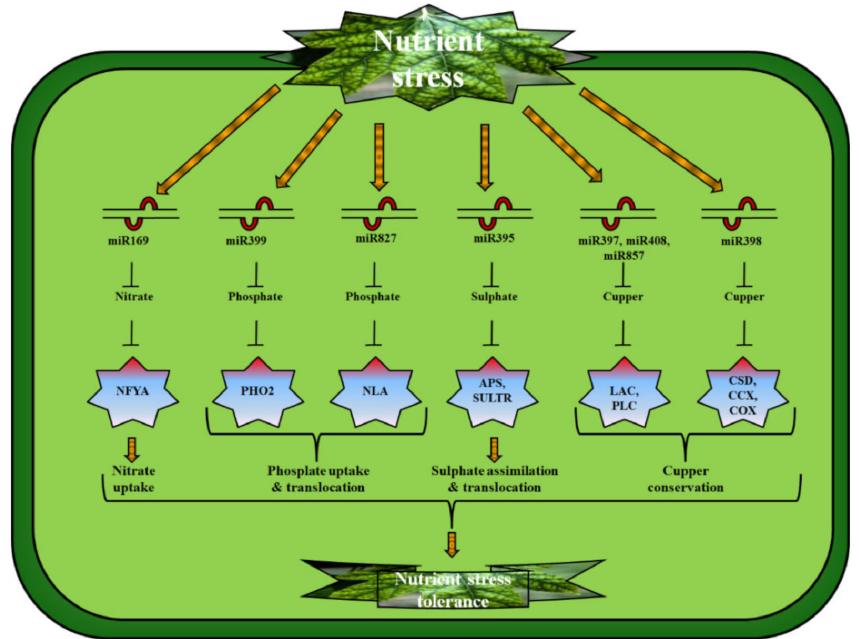
Figure 2. Plant microRNAs: their genetic targets and corresponding functions that induce tolerance against nutrient stress. miR169. miR399, miR827, miR395, miR397, miR408, MiR857, and miR398 respond to N, P, S, and Cu stress via targeting nuclear transcription factor Y subunit-alpha (NFYA), phosphate starvation-responsive gene (PHO2), nitrogen limitation adaptation (NLA), ATP sulfurylase (APS), sulfate transporter (SULTR), laccases (LAC), cold shock domain (CSD) , and cyclooxygenase (COX) to regulate N uptake, P uptake and translocation, S assimilation, and Cu conservation in plants, respectively, thereby having active roles in nutrient stress